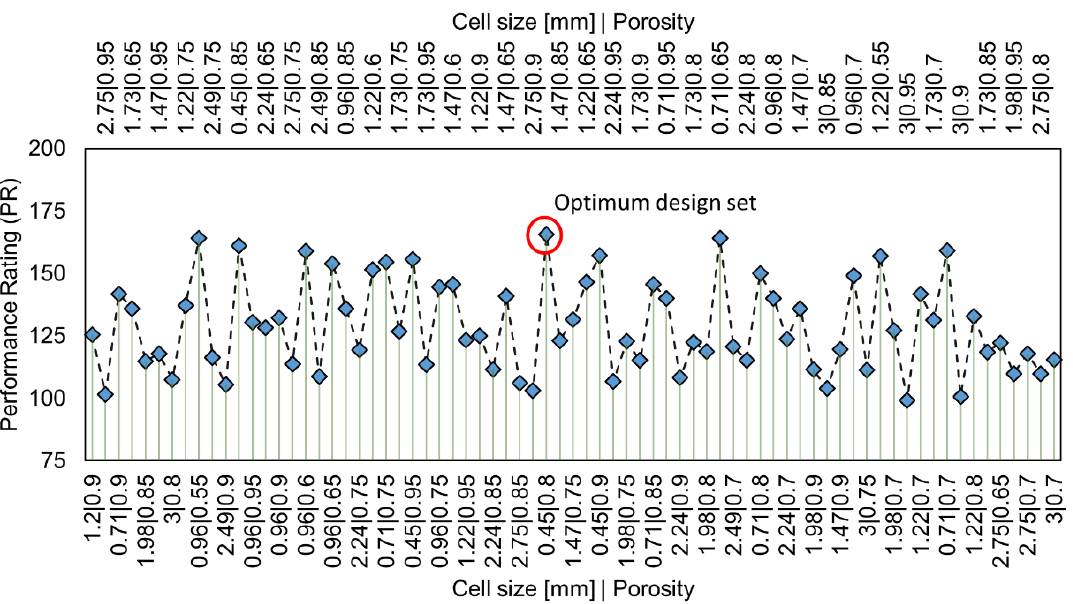
Figure 8. Performance Rating at Re p ~5000 (two horizontal axes, on top and bottom, denote design sets as combination of cell size and porosity, optimum design set yields maximum PR: 𝜙 = 0.45 mm, ε = 0.8).